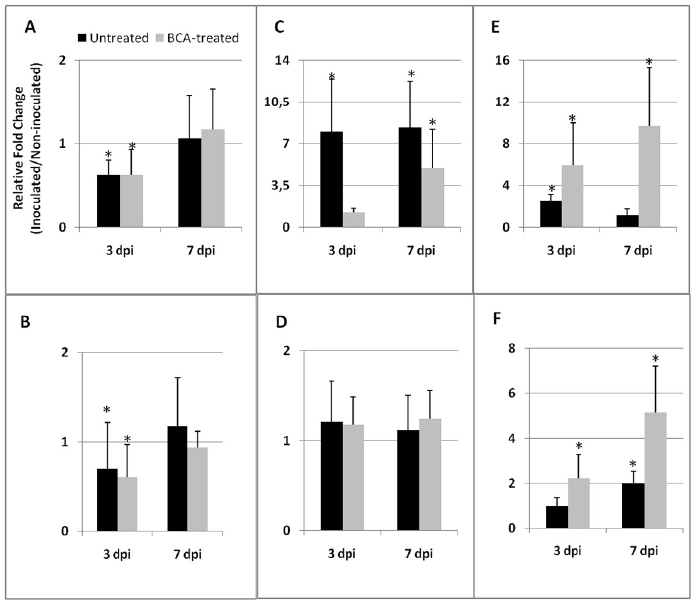
Fig 4. Expression of JERF3 , CAT , and ACO genesin tomato tissues of BCA-pretreated plants after inoculation with RKNs. Expression of JERF3 , CAT , and ACO genes was detected by quantitative real-time reverse-transcription polymerase chain reaction (qRT-PCR) in roots (A, C, and E, respectively)and leaves (B, D, and F, respectively)of nematode-infested susceptible tomato plants, untreated and BCA-pretreated, 3 and 7 days after inoculation (dpi) with 300 J2 M . incognita . Data are the mean fold changes (n = 6) ± SD in gene transcript levels of tissues from inoculated plants compared with tissues from non-inoculated control plants (the value of 1 indicates no change). An asterisk ( � ) indicates that the mean fold change is significantly different from 1 as determined by the non-parametric Kolmogorov- Smirnov test (P < 0.05). https://doi.org/10.1371/journal.pone.0213230.g004 Chitinase (CHI) and glucanase (GLU) are defense-induced enzymes in plants. Moreover, Reactive Oxygen Species (ROS), such as hydrogen peroxide (H O ),are normally produced in 2 2 response to biotic challenges because anti-microbial. H O is presumed to orchestrate basal 2 2 and systemic defense to invading pests. Antioxidant enzymes, such as ascorbate peroxidase (APX), degrade H O favoring biotic infections. We tested the activity of these three enzymes 2 2 in roots of untreated and BCA-treated tomato plants at 3 and 7 dpi (Table 3). CHI activity was Table 3. Effect of RKN inoculation on enzyme activities in roots of tomato plants untreated or pre-treated with BCAsat different days after inoculation (dpi). Enzyme Roots untreated Inoculated Roots untreated effect % Roots BCA-treated Inoculated Roots BCA-treated effect